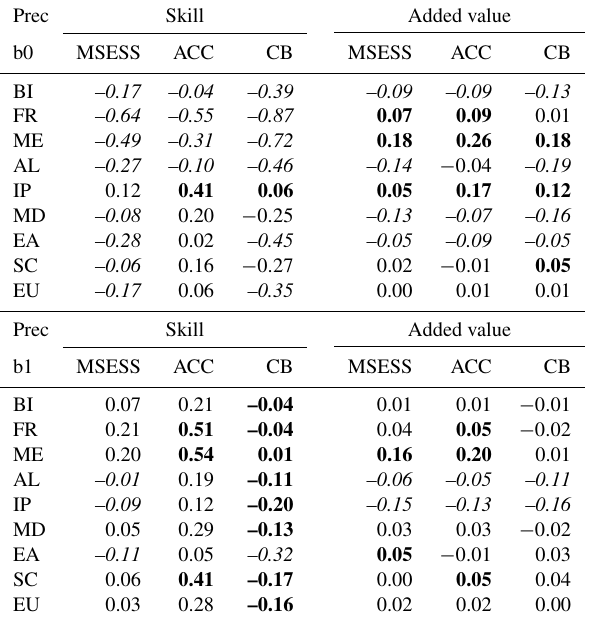
Table 2. As Table 1, but for